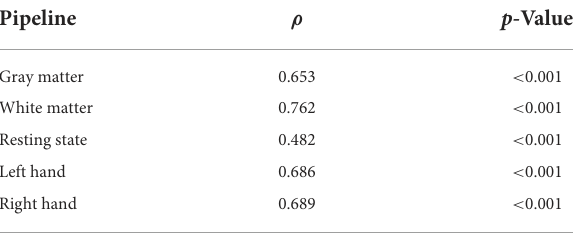
TABLE 5 Correlation between strength and sex prediction model coefficients * .